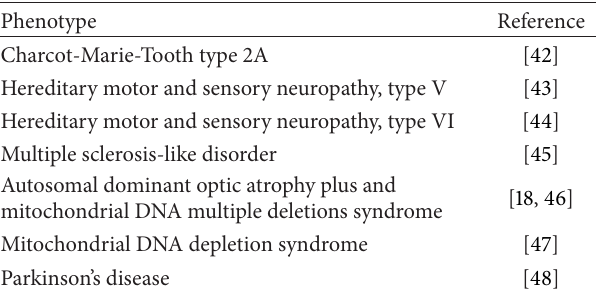
Table 2: Clinical phenotype variability associated with mutations in mitofusin